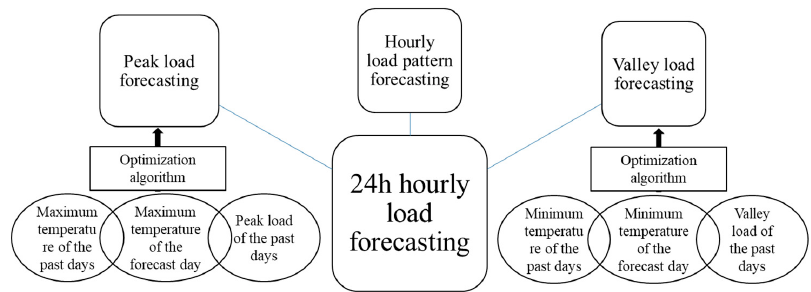
Figure 1. The selected model of STLF for Southern Power Corporation in Vietnam.